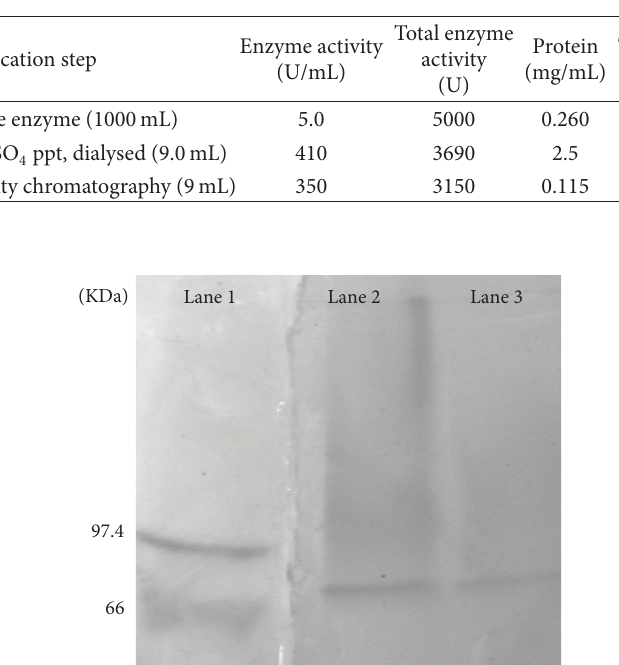
T 2: Puri�cation of PHB depolymerase of F. solani